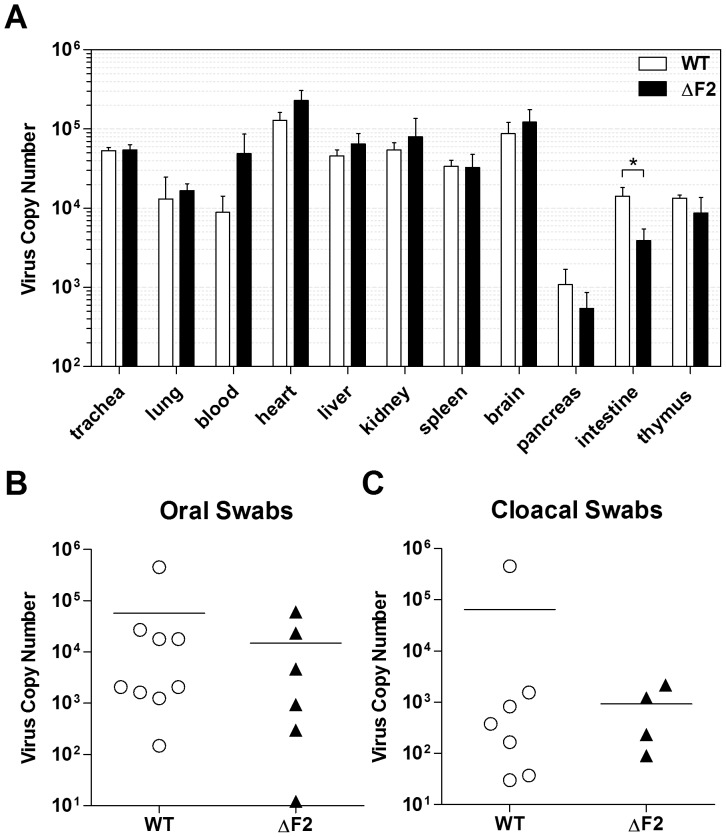
Tissue distribution and shedding of the wt and ΔF2 Nig06 HPAIV.(A) Viral titers of the indicated organs were measured by qRT-PCR at day 2 pi with 1000 PFU of wt or ΔF2 Nig06 virus. (B) Oral and (C) cloacal swabs were collected at day 2 pi to detect and quantify viral shedding using qRT-PCR.